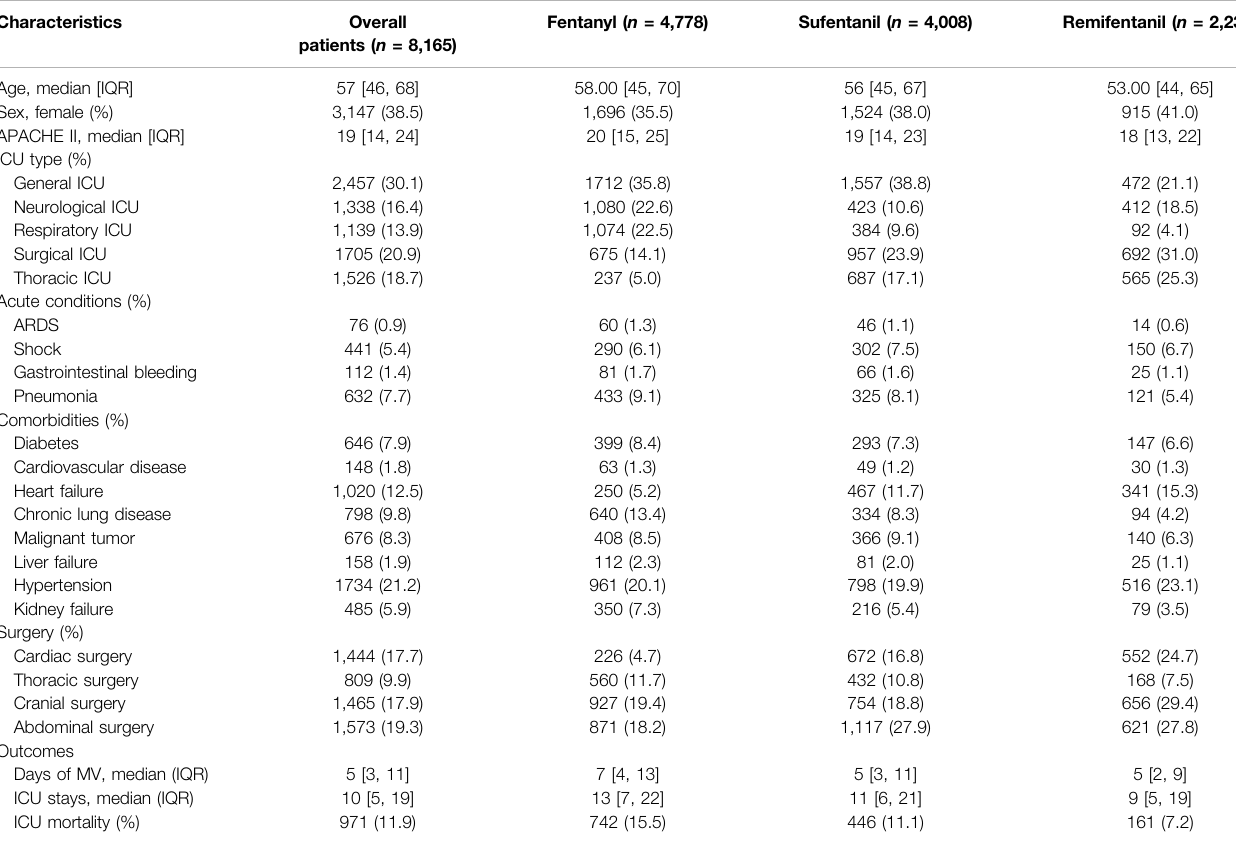
TABLE 1 | Clinical characteristics of included patients. Characteristics